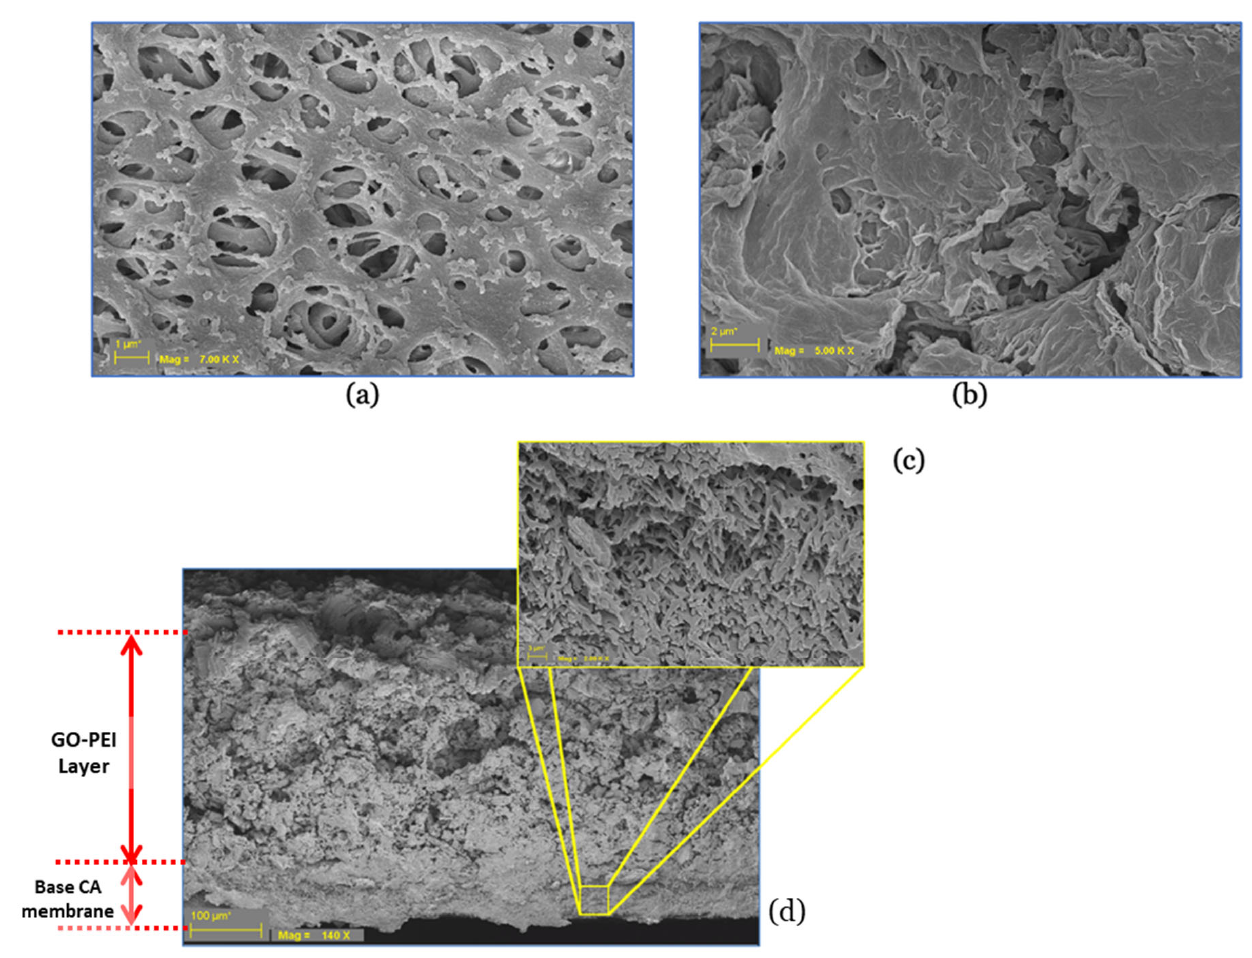
Figure 6. Surface morphology of a ( a ) pristine cellulose acetate membrane and ( b ) GO–PEI-modified cellulose acetate membrane, and cross-sectional images of the ( c ) pristine cellulose acetate membrane and ( d ) GO–PEI-modified cellulose acetate membrane.